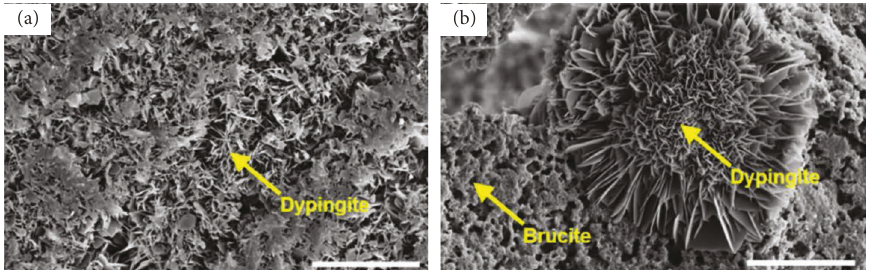
Figure 21: Observation of surface and internal microstructure of casting components by 10 μ m electron microscope [42].